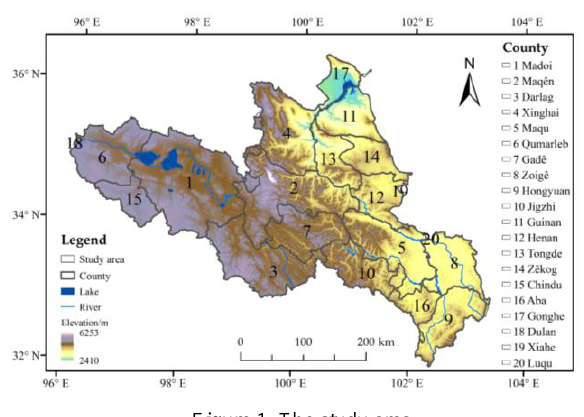
Figure 1. The study